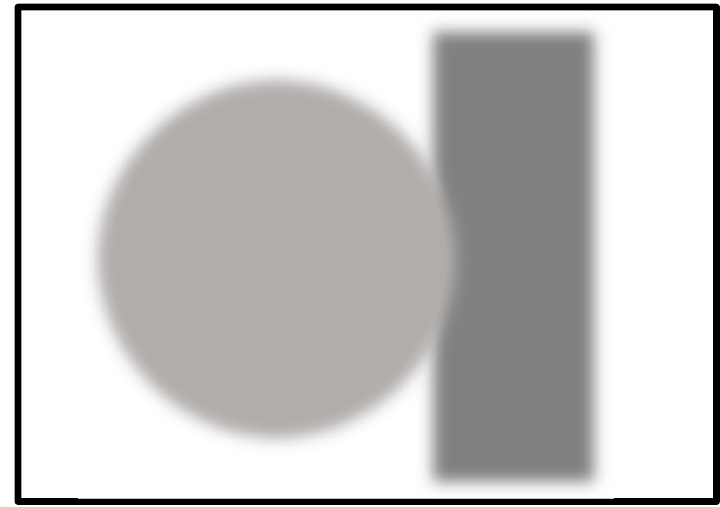
Figure 3. A better way to represent goal line technology.